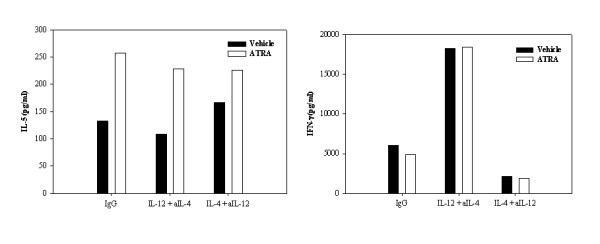
ATRA facilitates type 2 and inhibits type 1 cytokine switching even in cultures favoring Th1 or Th2 polarization. IL-5 and IFN-(proteins were quantitated by ELISA in supernatants of 48 h, anti-CD3 mAb (200 ng/ml)-activated PBMC (2.5 × 106/ml) treated with ETOH (□) or ATRA 10-7 M (■) under control (irrelevant isotype control mAb), Th1 (IL-12 and anti-IL-4 mAb) or Th2 (IL-4 and anti-IL-12) as described in the Methods. A representative experiment of three performed is shown and the results are expressed as pg/ml for IFN-(and IL-5. As the degree of IL-4 and IL-12 stimulation varied between donors, the data was not able to be pooled and analyzed statistically; however, all of the donors examined demonstrated similar patterns of enhancement and inhibition as shown in the current graph.